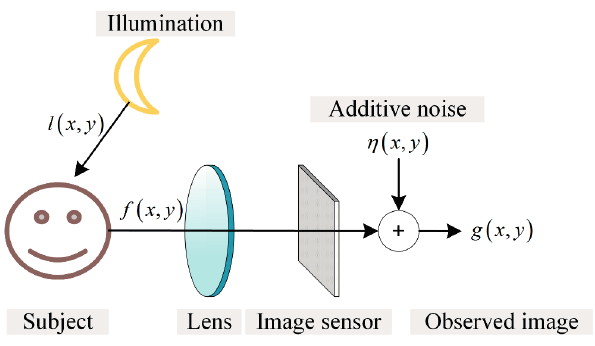
Figure 2. Image degradation model with an image sensor under low-light